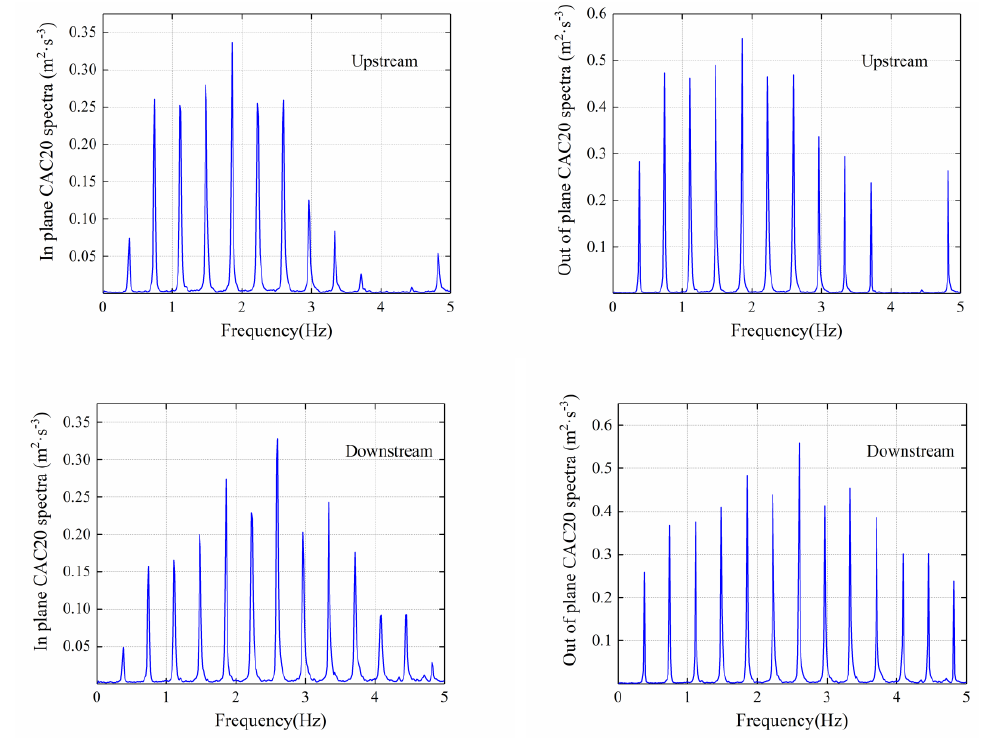
Figure 14. Spectra of the stay cable acceleration response.